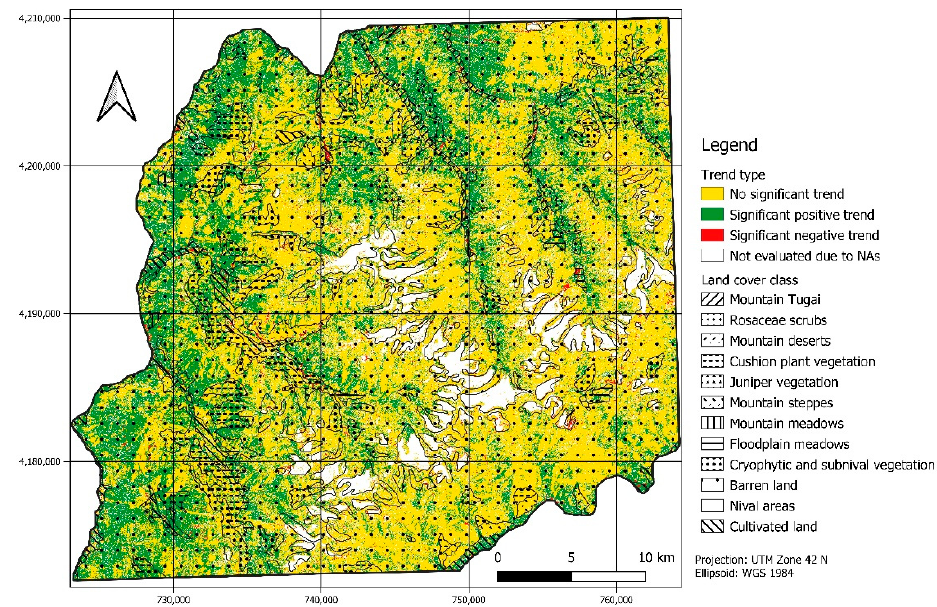
Figure 3. Classification map of the trend type overlaid by land cover classes according to Agakhan- janz [76].